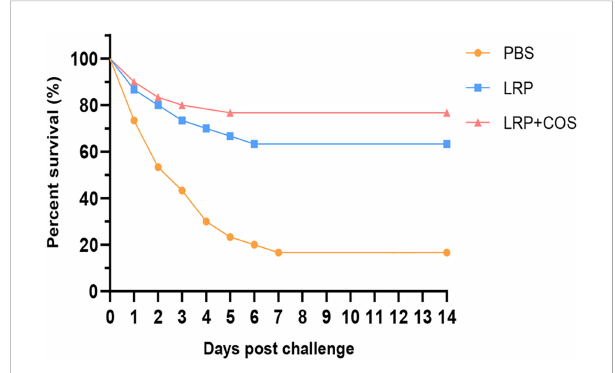
FIGURE 4 Relative survival rate of V. alginolyticus HY9901 after 14 days of challenge.